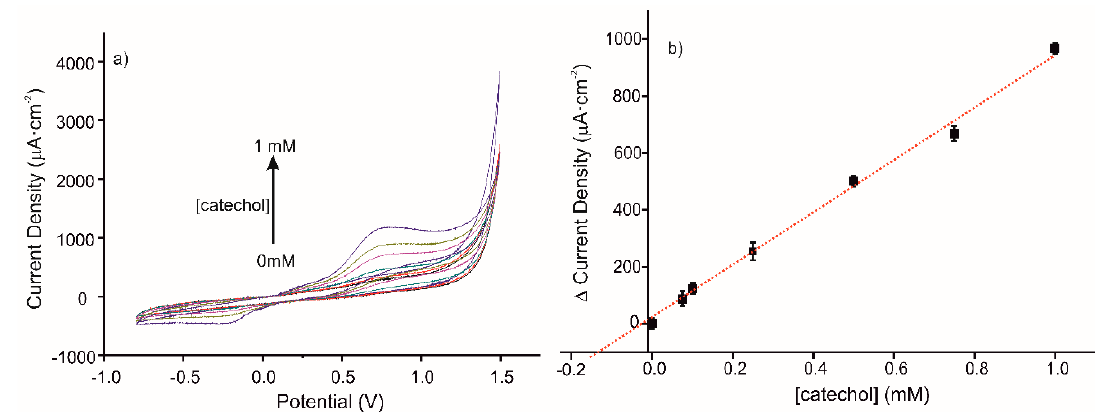
Figure 7. ( a ) Voltammetric responses of MIP CS-MWCNT / AuNP nanocomposite / BDD sensor in 10% diluted wine solution in 0.1 M, pH 7.4 PBS solution, for increased concentration of catechol (0, 0.075, 0.1, 0.25, 0.5, 0.75, and 1 mM). ( b ) Calibration curve for standard additions of catechol in a diluted wine sample (10% diluted in 0.1 M, pH 7.4 PBS solution), using the CS-MIP / BDD sensor.